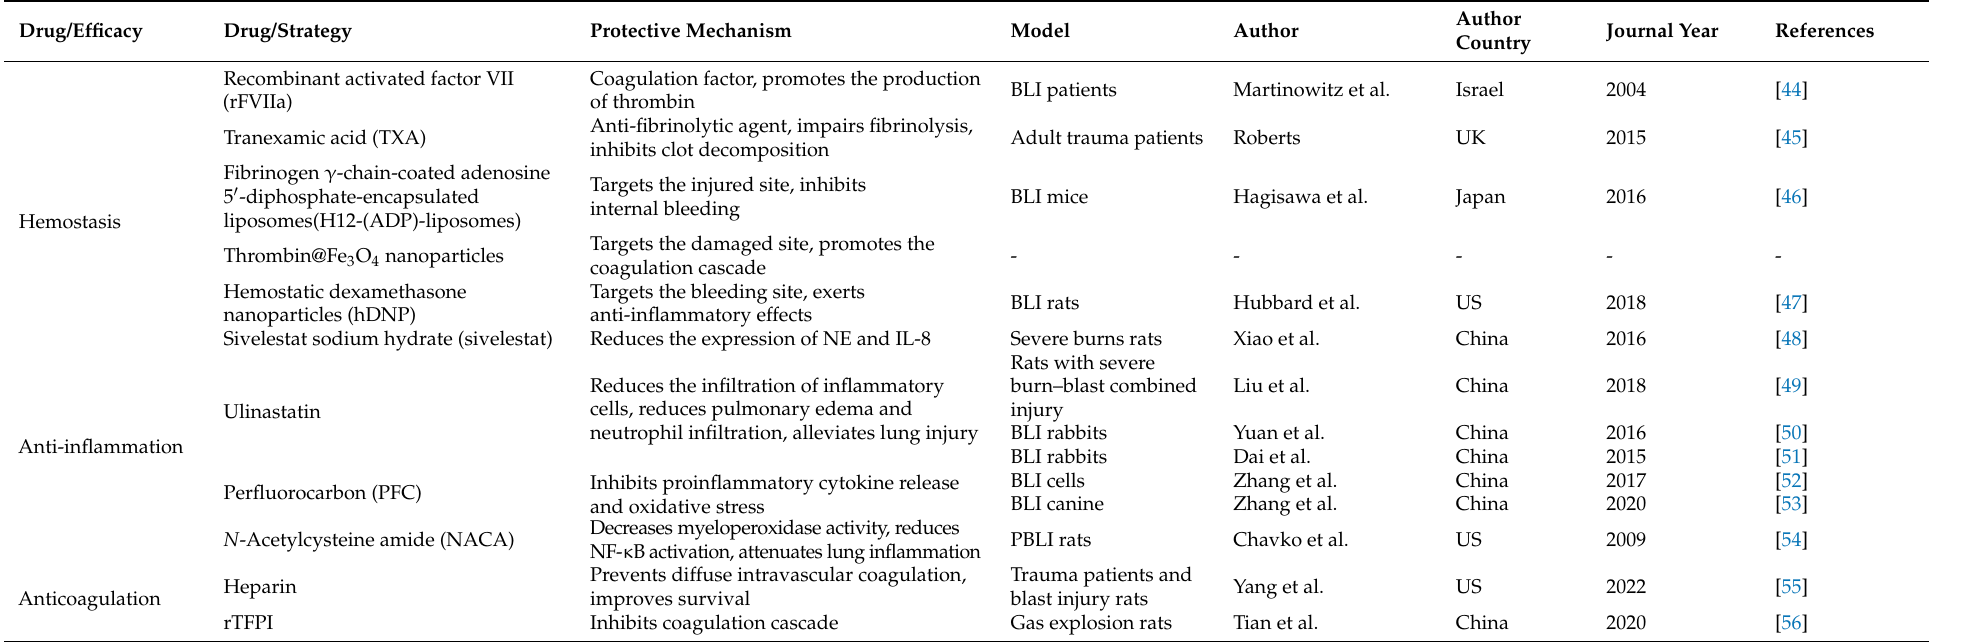
Table 2. Pharmacotherapies for primary blast lung